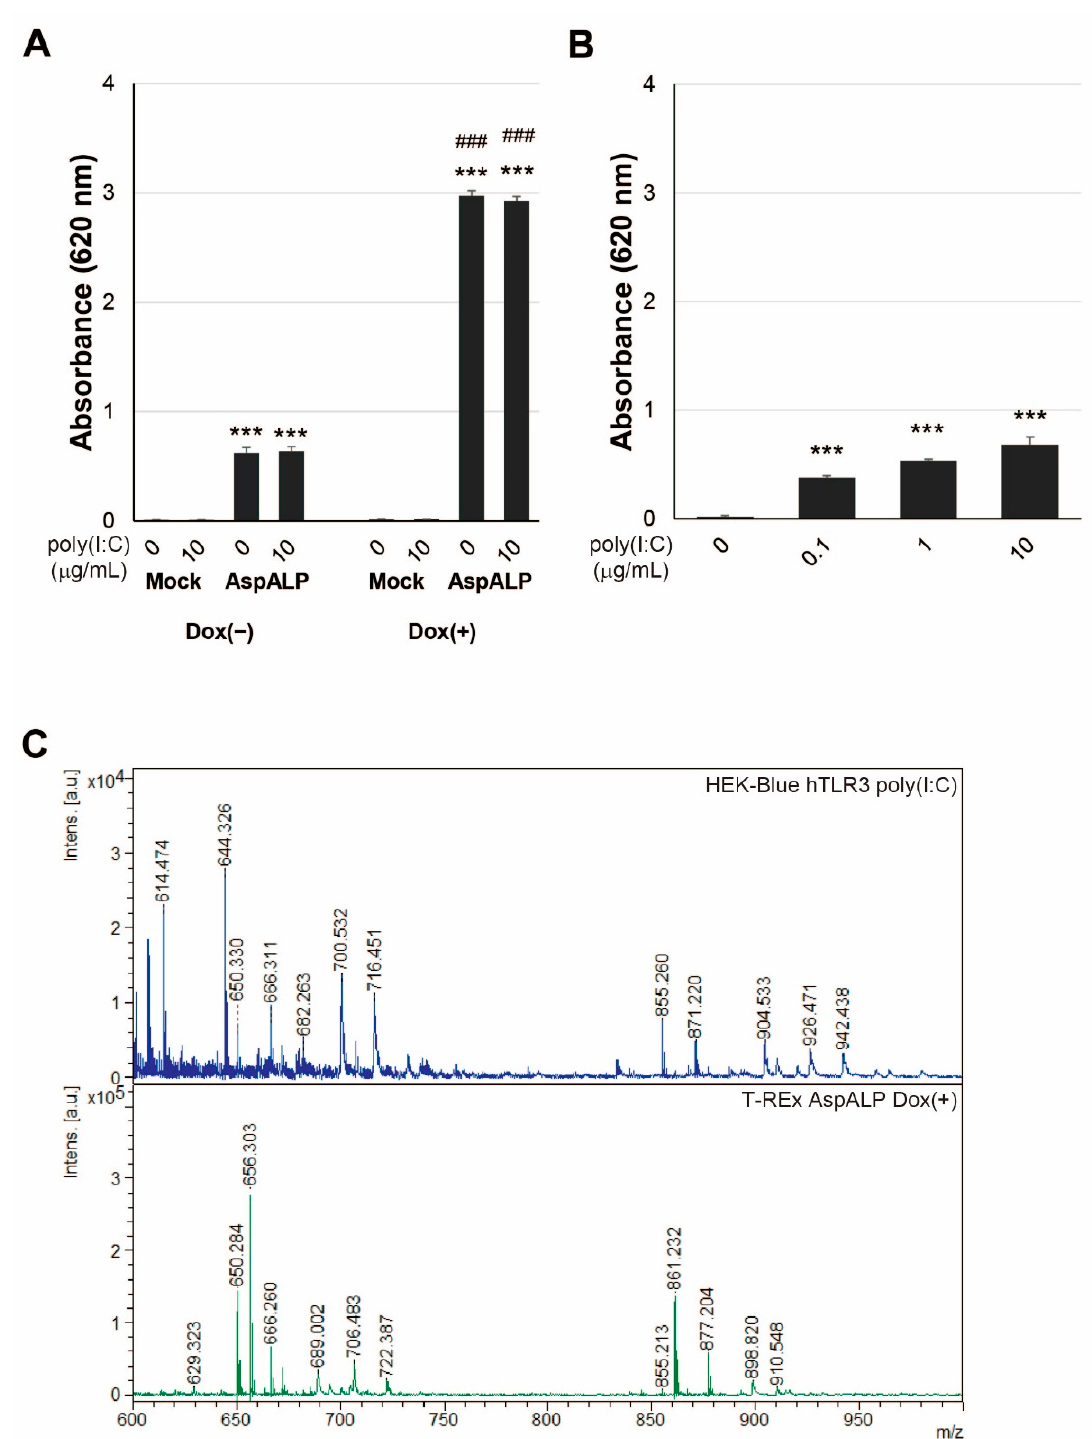
Figure 1. SEAP is released from poly(I:C)-stimulated cells. ( A ) The SEAP activity of T-REx Mock (Mock) and T-REx AspALP (AspALP) cells in the presence or absence of Dox at 1 μ g/mL or poly(I:C) at 10 μ g/mL. *** p < 0.001 vs. T-REx Mock cells in the absence of poly(I:C). ### p < 0.001 vs. T-REx AspALP cells in the absence of Dox. ( B ) The SEAP activity of HEK-Blue hTLR3 cells in the presence of poly(I:C) at 0–10 μ g/mL. *** p < 0.001 vs. HEK-Blue hTLR3 cells in the absence of poly(I:C). ( C ) The peptide solution extracted from exosomes of HEK-Blue hTLR3 cells 3 days after poly(I:C) treatment at 10 μ g/mL and T-REx AspALP cells 3 days after Dox treatment at 1 μ g/mL was analyzed by MALDI-TOF MS.